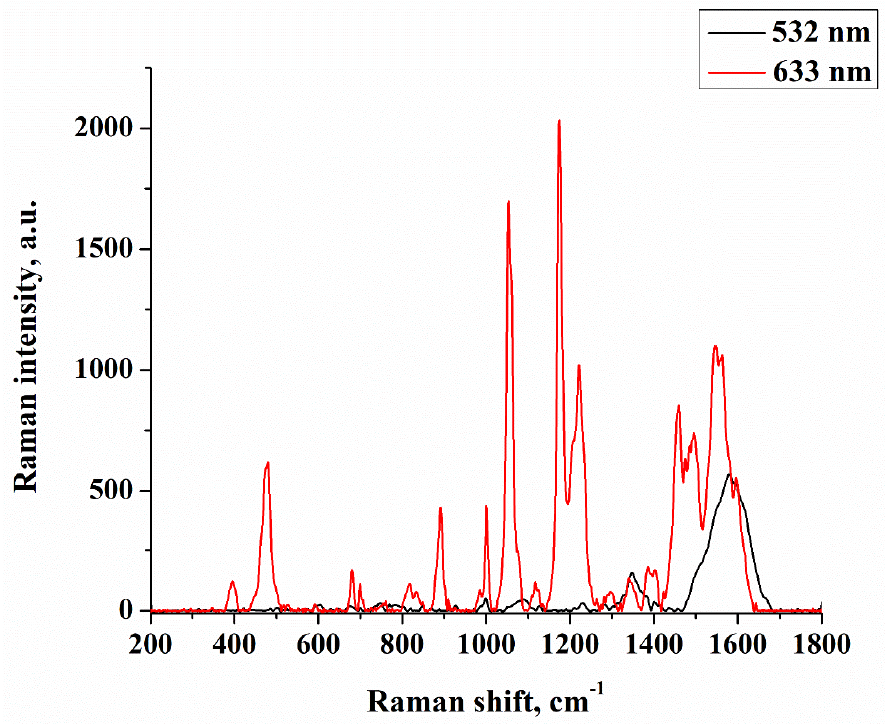
Figure 4. Surfaced-enhanced Raman signal of riboflavin measured with two excitation wavelengths. The same comparison for the other analyte, i.e., R6G, is provided in Figure 5. The characteristic peaks of R6G can be detected for both excitations. In terms of the enhance- ment, it is better with 532 nm excitation; the EF for R6G is 110 for the 532 nm excitation and only 14 for 633 nm.